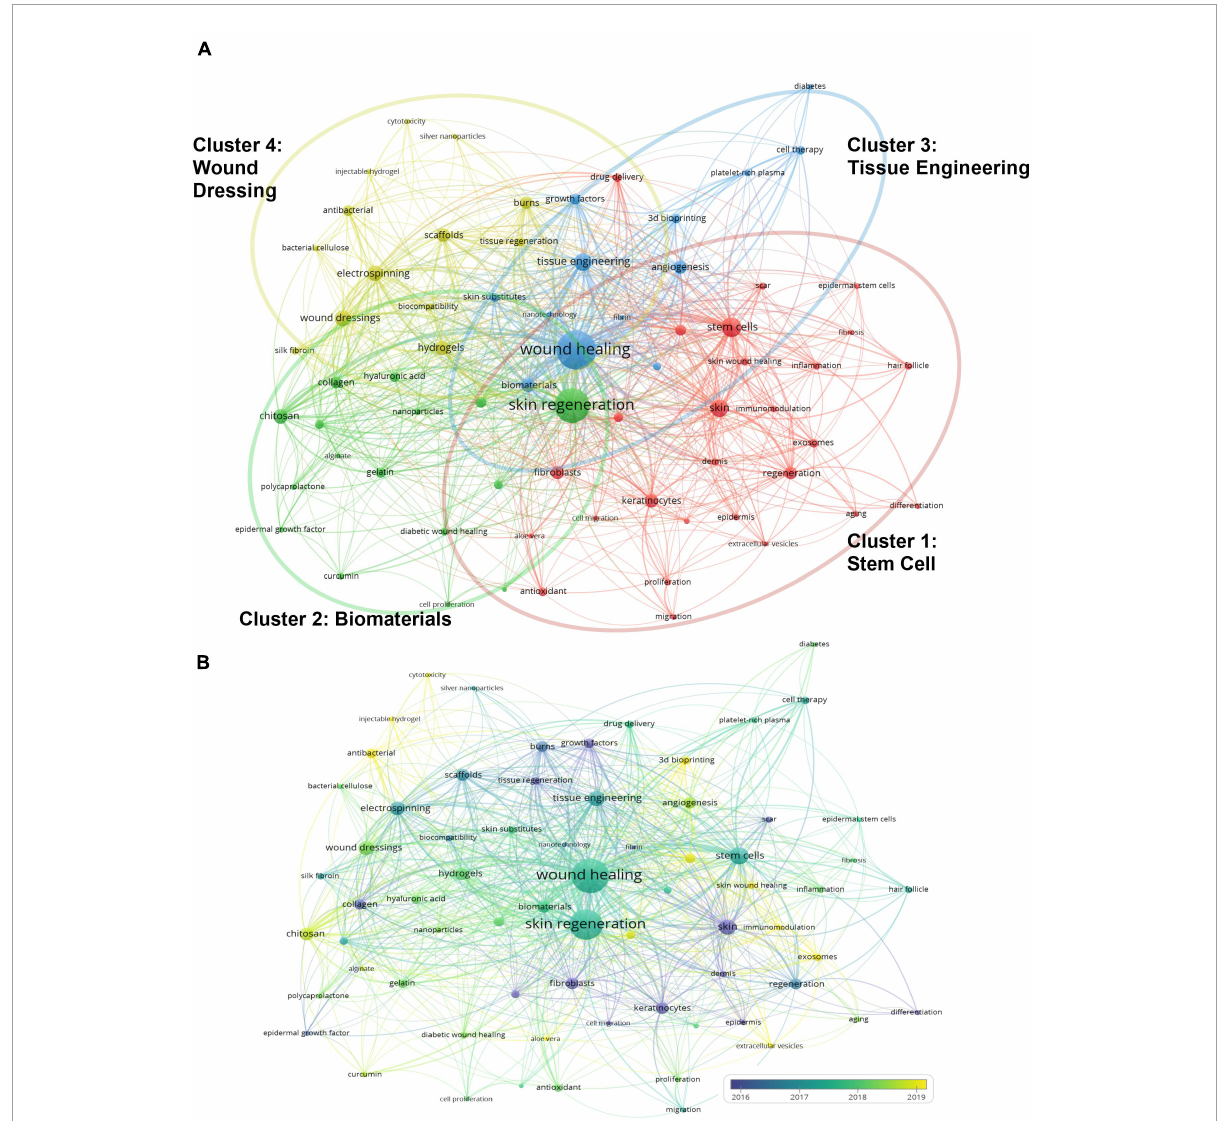
FIGURE6 Analysis of keywords in publications on skin regeneration. (A) Map of the keywords concerning skin regeneration. The keywords were divided into three clusters, indicated with different colors. The large icon indicates keywords with high frequencies. (B) The keyword distribution is presented according to the average date of appearance, with blue representing an early appearance and yellow indicating a recent appearance. The smaller the distance between two keywords, the greater the frequency of their co-occurrence. Minimum number of occurrences of one keyword: